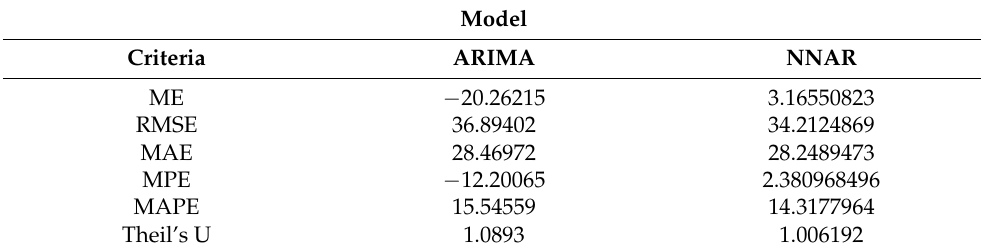
Table 5. Criteria for evaluation of forecasts.